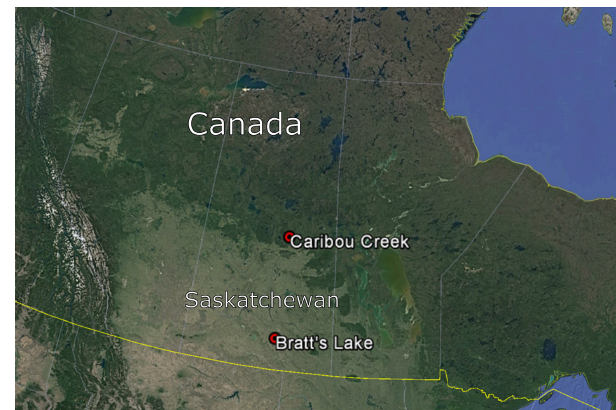
Figure 3. Location of the Caribou Creek and Bratt’s Lake SK sites in western Canada (base map obtained from Google Earth; Data SIO, U.S. Navy, GEBCO © 2018 Google; Image Land-